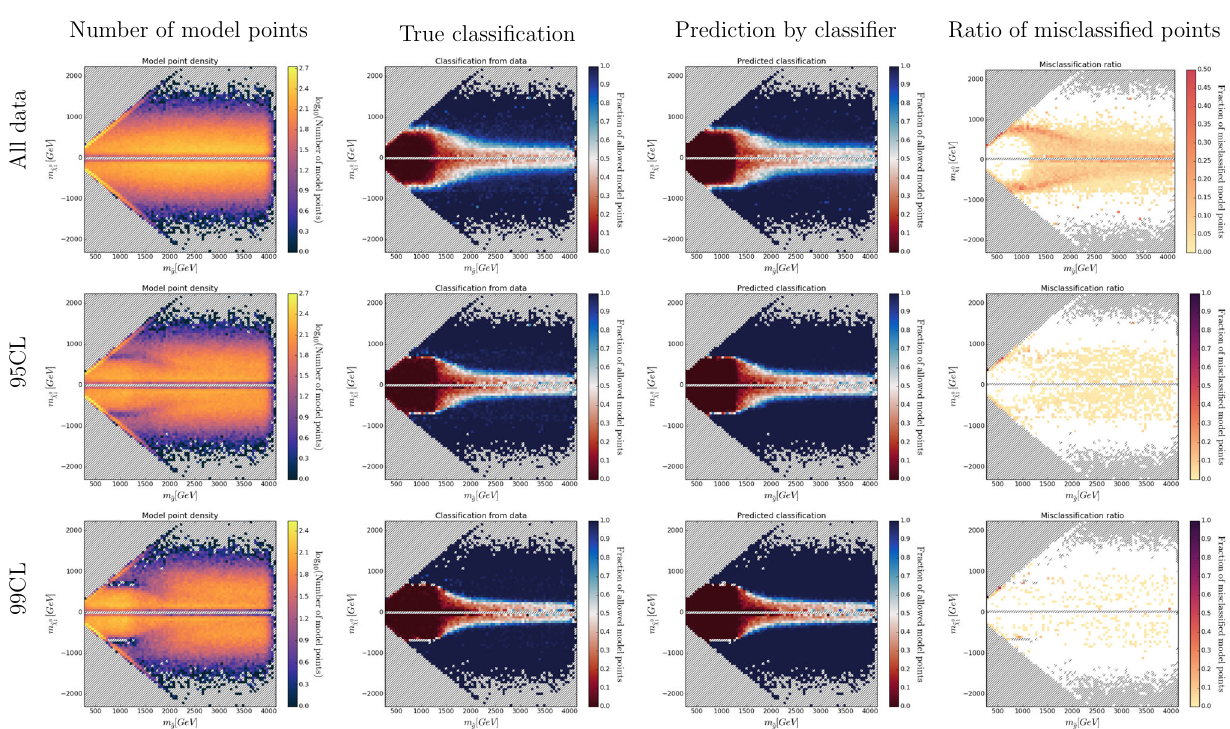
Fig. 7 Color histograms for a projection of the 19-dimensional classification and the out-of-bag prediction, respectively. The last col- umn shows the fraction of misclassified model points, with white areas pMSSMparameterspaceonthe m ˜ g – m ˜ χ 0 plane.The color inthe second 1 denoting no misclassifications. The dashed bins contain no data and thirdcolumn indicatesthefractionofalloweddatapointsforthetrue